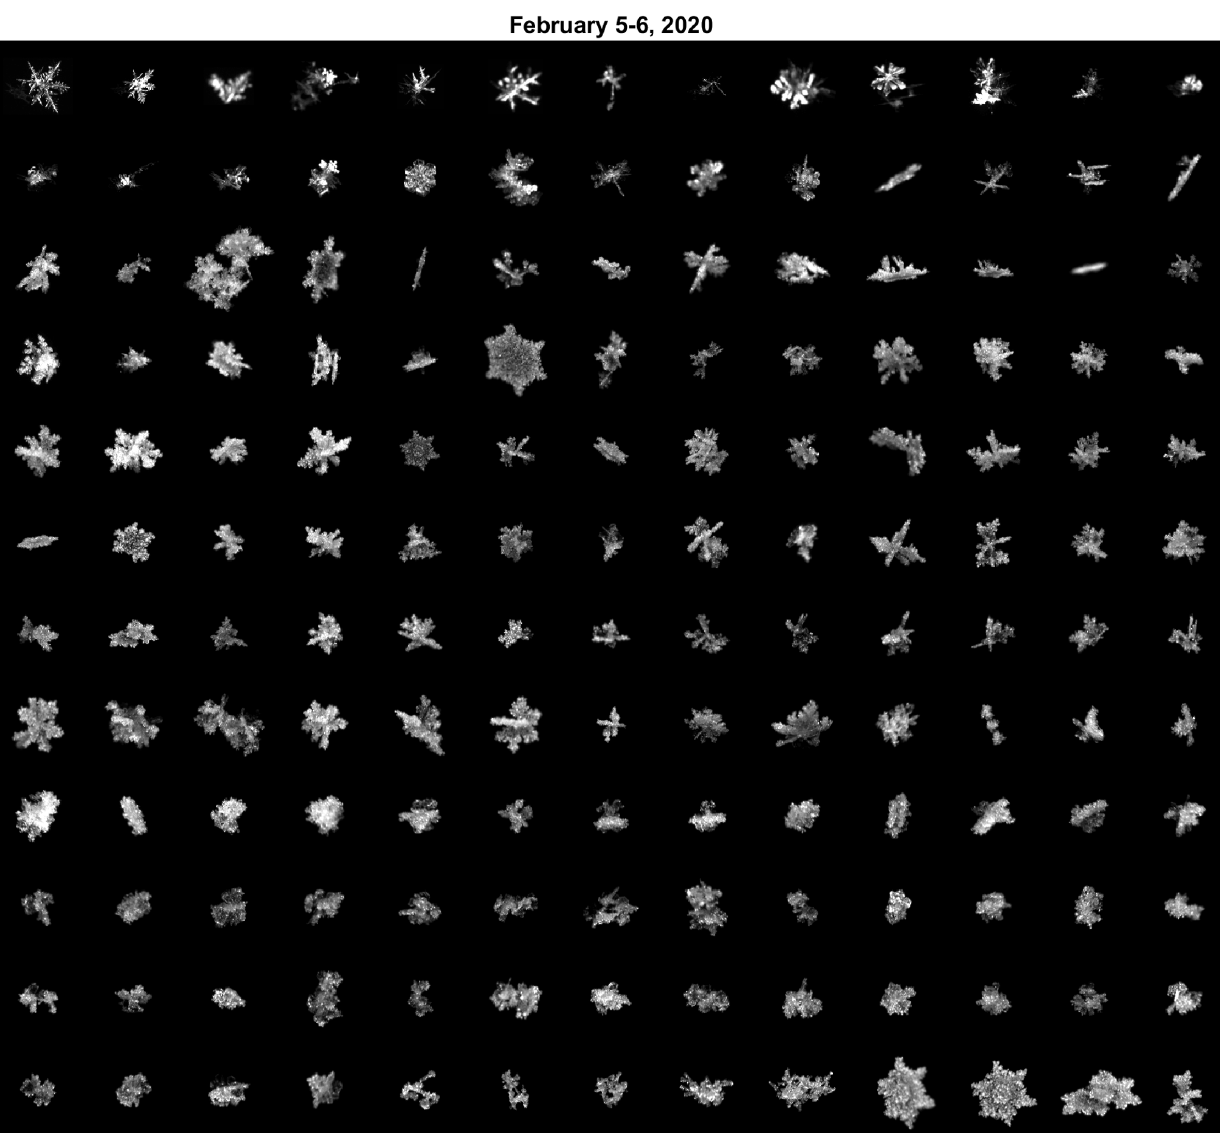
Figure 3. A selection of MASC snowflake images obtained between 5 and 6 February